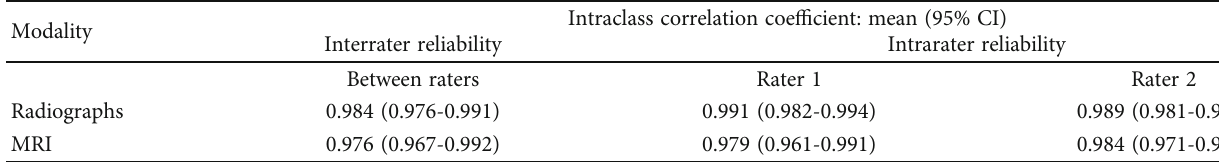
Table 2: Inter- and intraobserver reliability for skeletal age assessment.